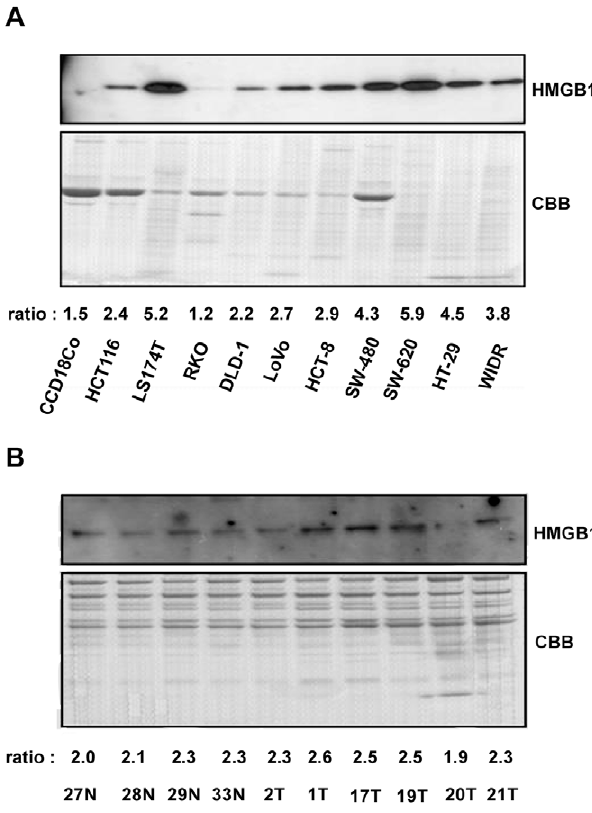
Figure 1. HMGB1 is secreted from colon cancer cells and detected in the blood of cancer patients. HMGB1 in the culture media of colon cancer cells (A) and the sera of colorectal cancer patients (B) exhibited varying degrees of HMGB1 secretion. Culture media were collected, concentrated using a specified column, and the blood samples were depleted of the six most abundant proteins using a MARS column. (A) Normal colon fibroblast cell line CCD18Co did not secrete visible amounts of HMGB1 in the culture media; however most tumor cells secreted HMGB1 with slight differences between tumor cells. Coomassie Brilliant Blue staining indicated that equal amounts of proteins were loaded onto SDS-PAGE gels. (B) Human serum proteins were depleted, and HMGB1 secretion was examined. HMGB1 secretion was observed in both healthy controls and colorectal cancer patients, but elevated serum HMGB1 levels were noted in cancer patients. The numbers provided for the cases match those in our tissue bank database. N represents normal healthy controls, and T represents colorectal carcinoma tumor patients. Coomassie Brilliant Blue staining indicated that equal amounts of proteins were loaded onto SDS-PAGE gels. The ratio of HMGB1:CBB was calculated by TINA program and depicted under the images.